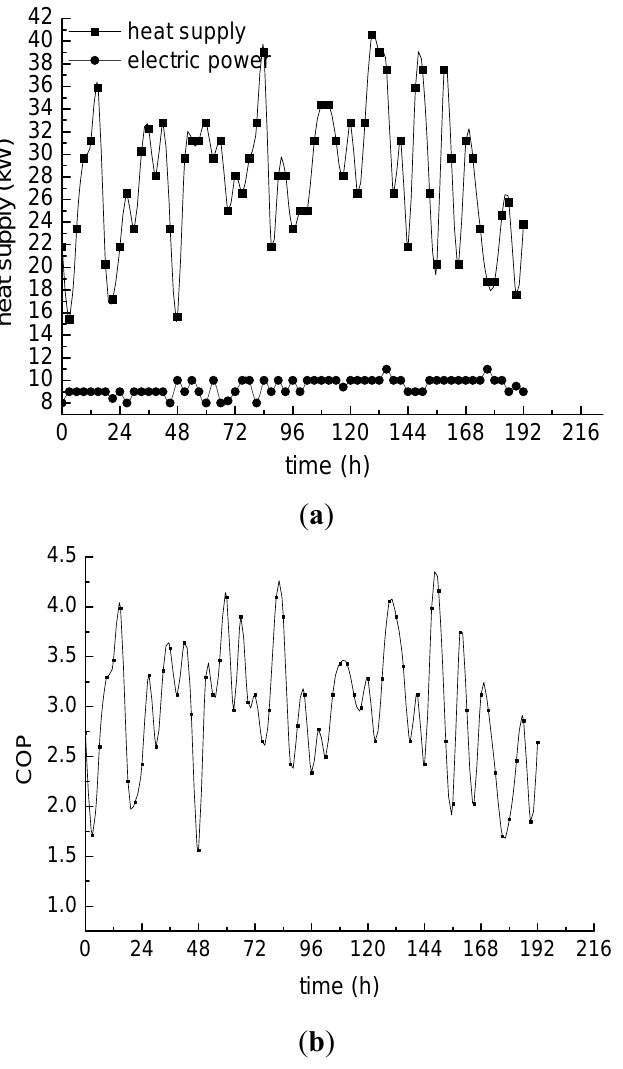
Figure 11. Energy and performance analysis results of the system. ( a ) Thermal and electrical energy; ( b )